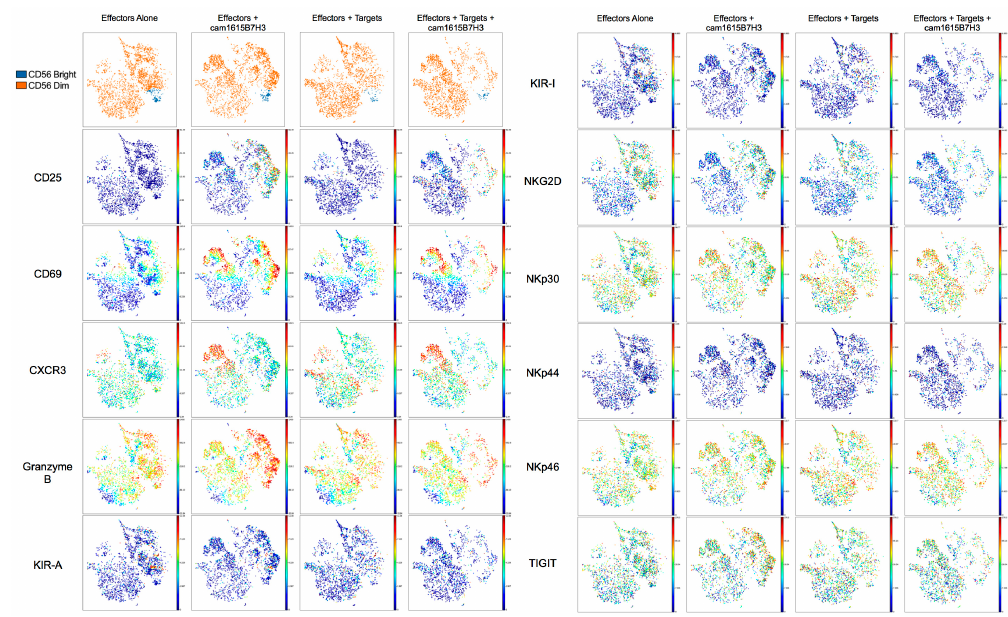
Figure 6. High dimensional analysis of cam1615B7H3 activated NK cells. Concatenated analysis of three donors PBMCs incubated alone, with 30 nM cam1615B7H3 TriKE, with OVCAR8 tumor (2:1 E:T), or with 30 nM cam1615B7H3 TriKE and OVCAR8 tumor. Data was visualized in viSNE (Cytobank) and gated on CD45 + CD56 + CD3 − cells. With the exception of the CD56 plot, color represents protein intensity (red = highest, and dark blue = lowest).